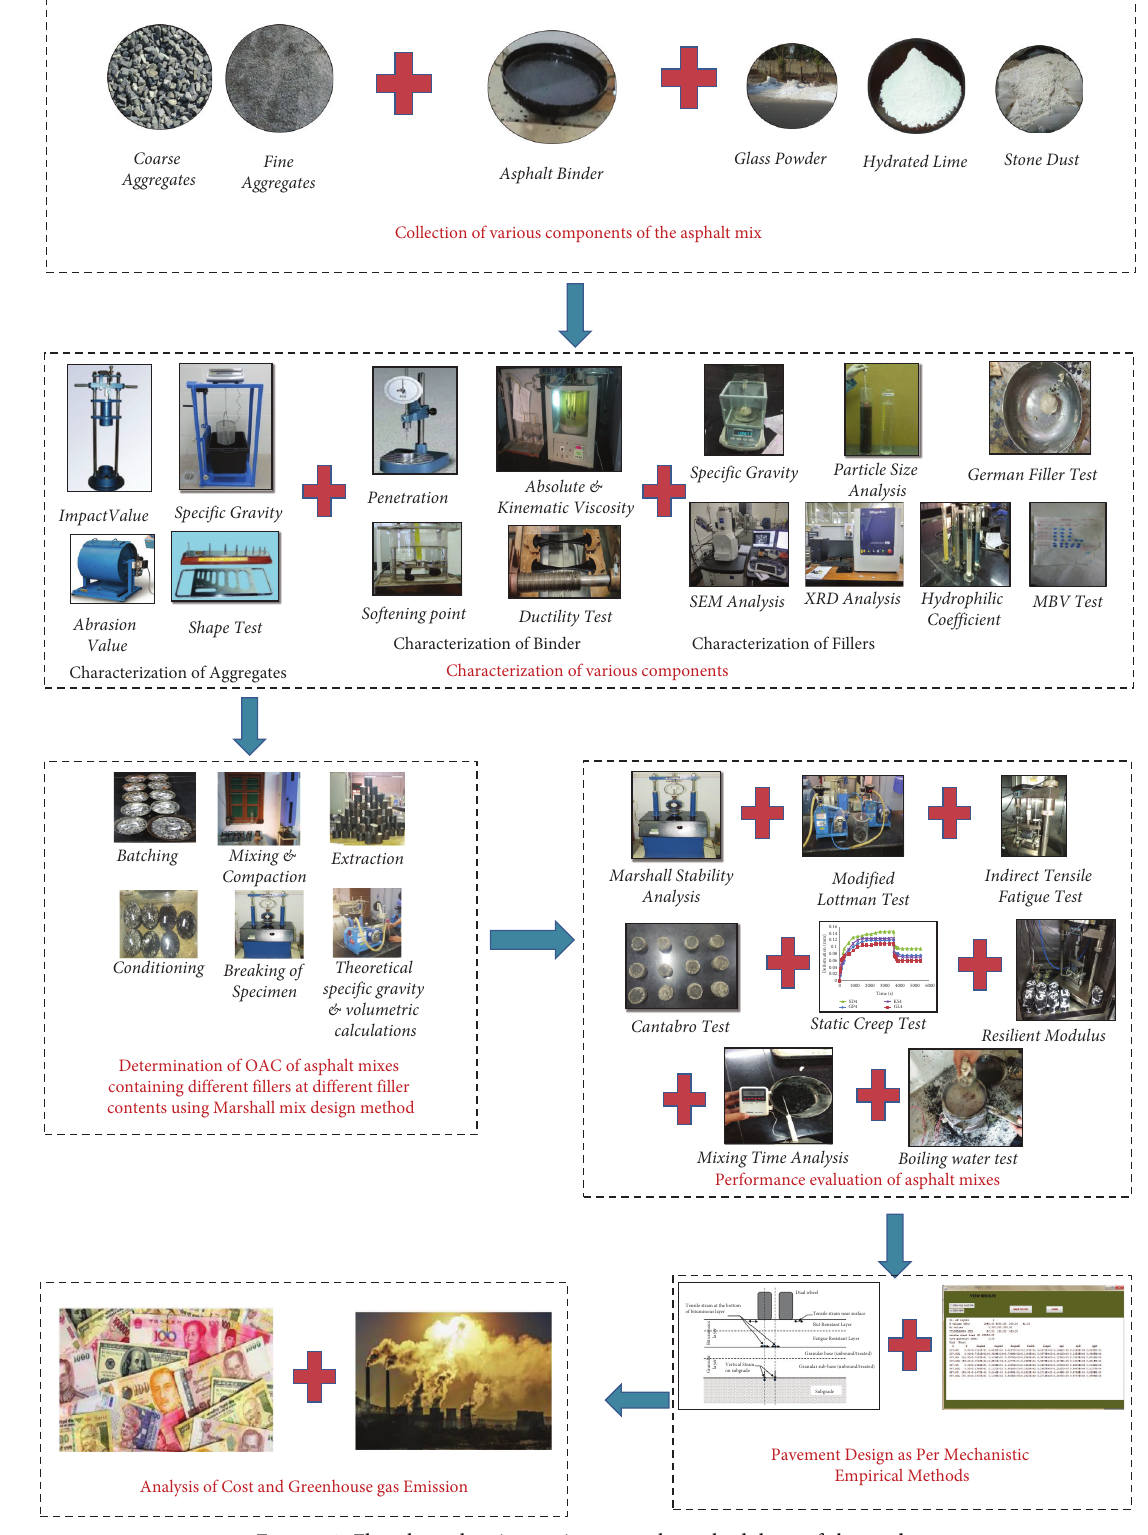
Figure 1: Flowchart showing entire research methodology of the